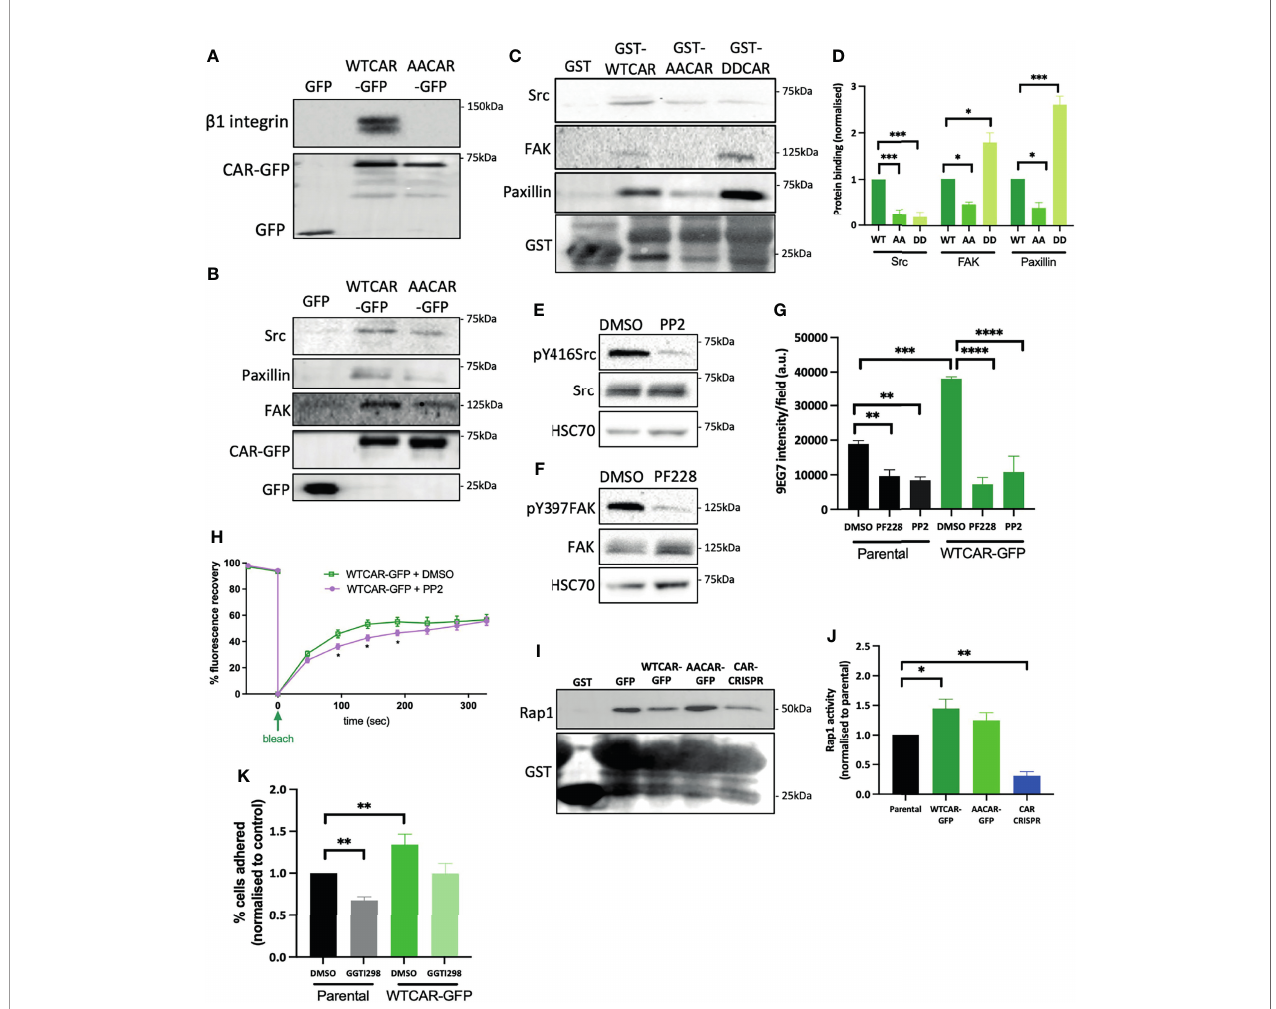
FIGURE 5 | CAR forms a complex with focal adhesion proteins. (A) Representative western blot of immunoprecipitation of b 1 integrins from speci fi ed cell lines probed for b 1 integrin and GFP. Representative of 5 independent experiments. (B) Western blots of immunoprecipitation of GFP or GFP-CAR from lysates from speci fi ed cell lines probed for indicated focal adhesion proteins and GFP. Representative of 5 independent experiments. (C) Western blots of GST pulldowns using GST only or GST-CAR cytoplasmic tail (WT, AA, DD) using from lysates from CMT parental cells probed for indicated focal adhesion proteins and GST. (D) Quanti fi cation of blots as in C from 5 independent experiments. (E, F) Western blot of lysates from CMT parental cells treated with Src inhibitor [PP2, 1 m M, (E) ] or FAK inhibitor [PF228, 1 m M, (F) ] probed for indicated proteins. (G) Quanti fi cation of active b 1 integrins (9EG7) from images of speci fi ed CMT cell lines treated with DMSO, PP2 or PF228. Data is from at least 10 fi elds of view (5-10 cells per fi eld) per condition. Representative of 3 independent experiments. (H) Quanti fi cation of recovery curves of fl uorescence intensity for FRAP data from WTCAR-GFP CMT cells +/-PP2. Data is from at least 15 different ROIs per cell line, shown as mean +/-SEM, representative of 3 independent experiments. (I) Representative Western blots of lysates from Rap1 activity pulldown assays from speci fi ed CMT cell lines, probed for Rap1 and GST. (J) Quanti fi cation of data as in (I) , pooled from 5 independent experiments. (K) Quanti fi cation of CMT parental and WTCAR-GFP cell adhesion to Matrigel after 2h, following pre-treatment with DMSO or Rap1 inhibitor (GGTI298, 5 m M) normalised to control. Data is from 3 wells per cell line, representative of 3 independent experiments. All values are mean ± SEM. P values *p < 0.05, **p < 0.01, ***p < 0.0005, ****p <